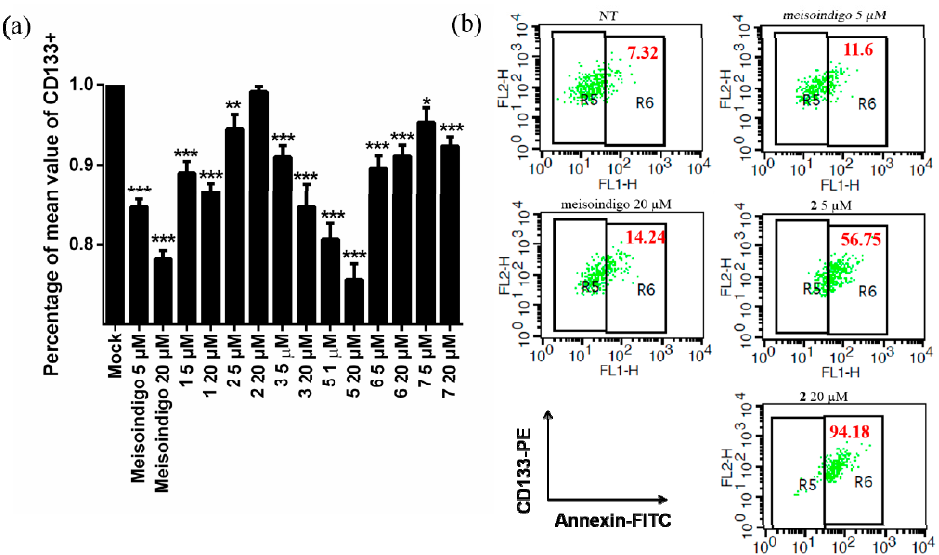
Figure 6. ( a ) Bromo-meisoindigos reduced CD133+ population in JoPaca-1 cells. The percentage of CD133 expression was determined by FACS analysis and the mean value was normalized to mock treatment; ( b ) Meisoindigo and 6-bromo-meisoindigo induced apoptosis in JoPaca-1 cells. Cells were treated as indicated for 24 h and FACS analysis was performed.